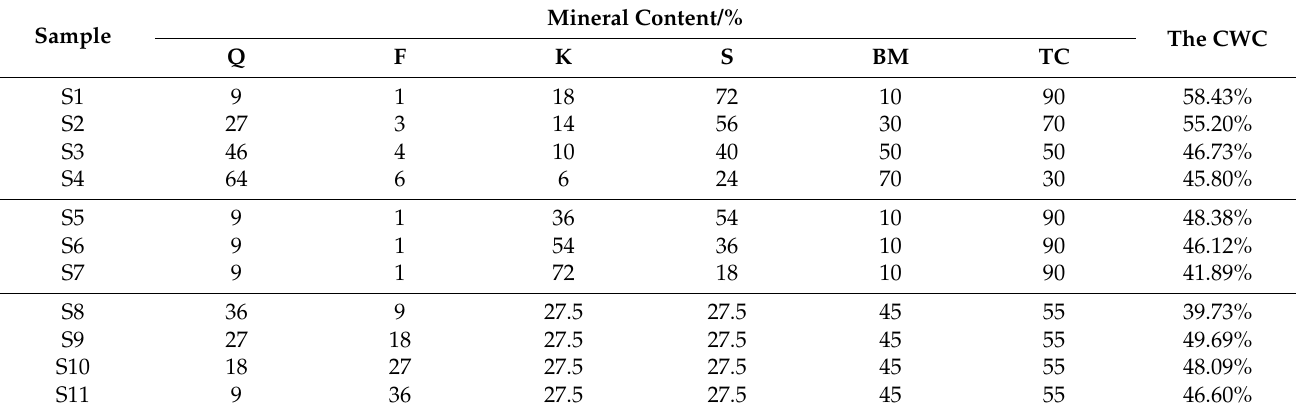
Table 3. The CWC of samples with different minerals.